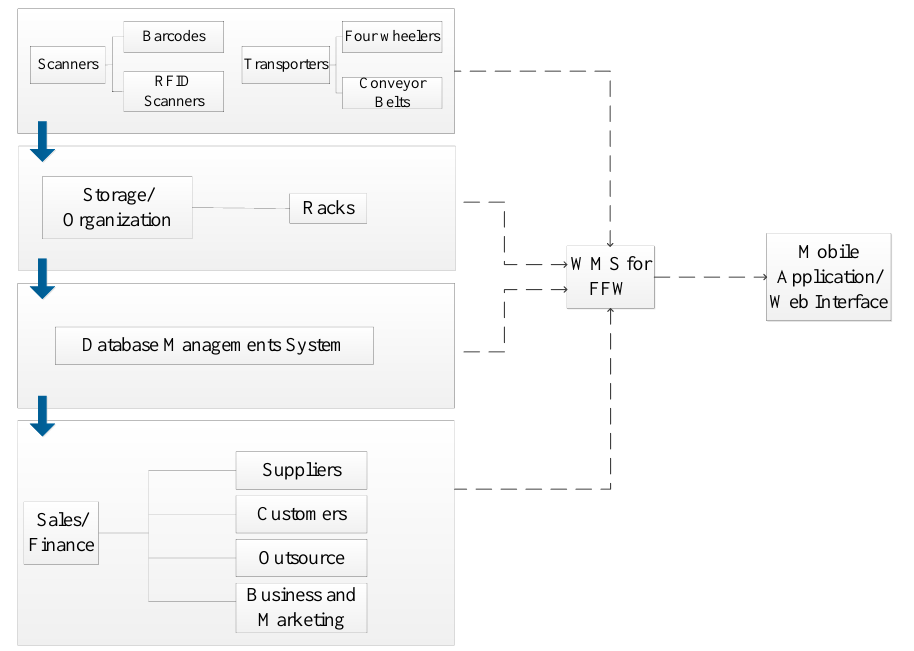
Figure 8. Functional view (for the case